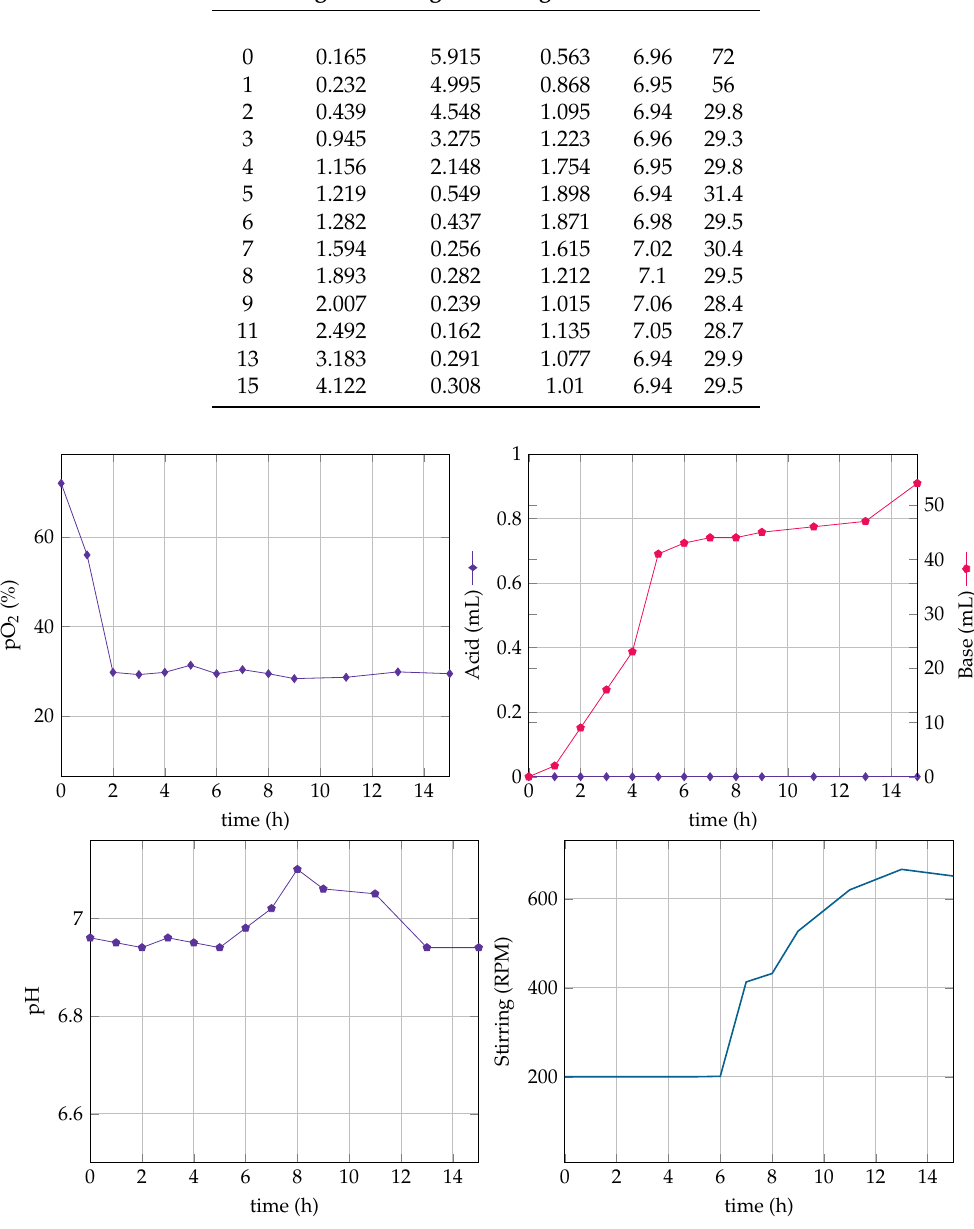
Figure 16. Experiment 1: Time evolution of pO 2 , acid and base concentrations, pH, and